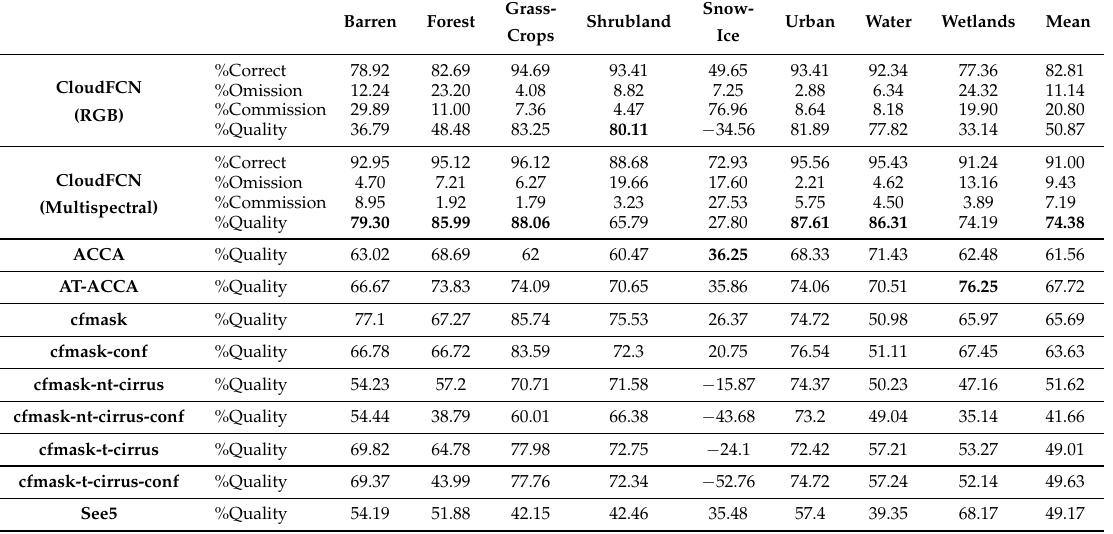
Table 3. Cloud detection results for Biome dataset. RGB gives performance of algorithm with Landsat 8 bands 4,3,2 as input. Multispectral uses all 11 Landsat 8 bands. Comparison with 9 other algorithms validated in [33] are given at the bottom, with Quality values derived from the values given in the study. For each biome, the best-performing algorithm is in bold. The multispectral performs best overall, with an average quality metric 6.7% greater than the next highest,